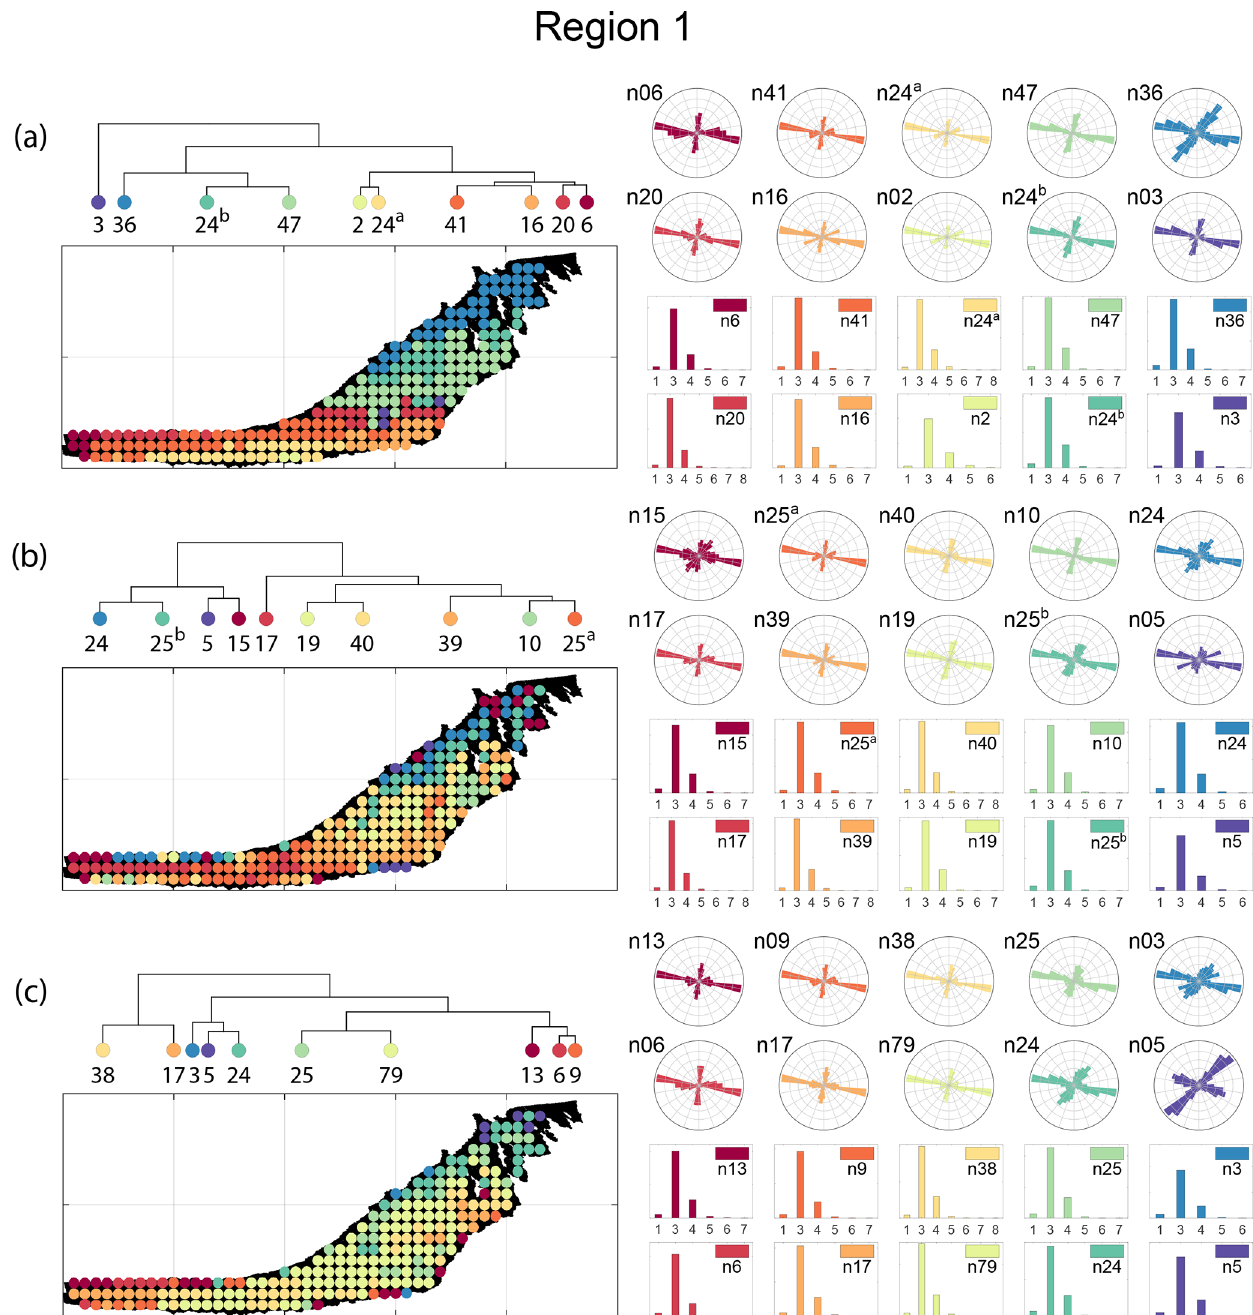
Figure 18. Variation in fracture orientations and topological summary for Region 1 corresponding to (a) fingerprint distance, (b) D-measure, and (c) portrait